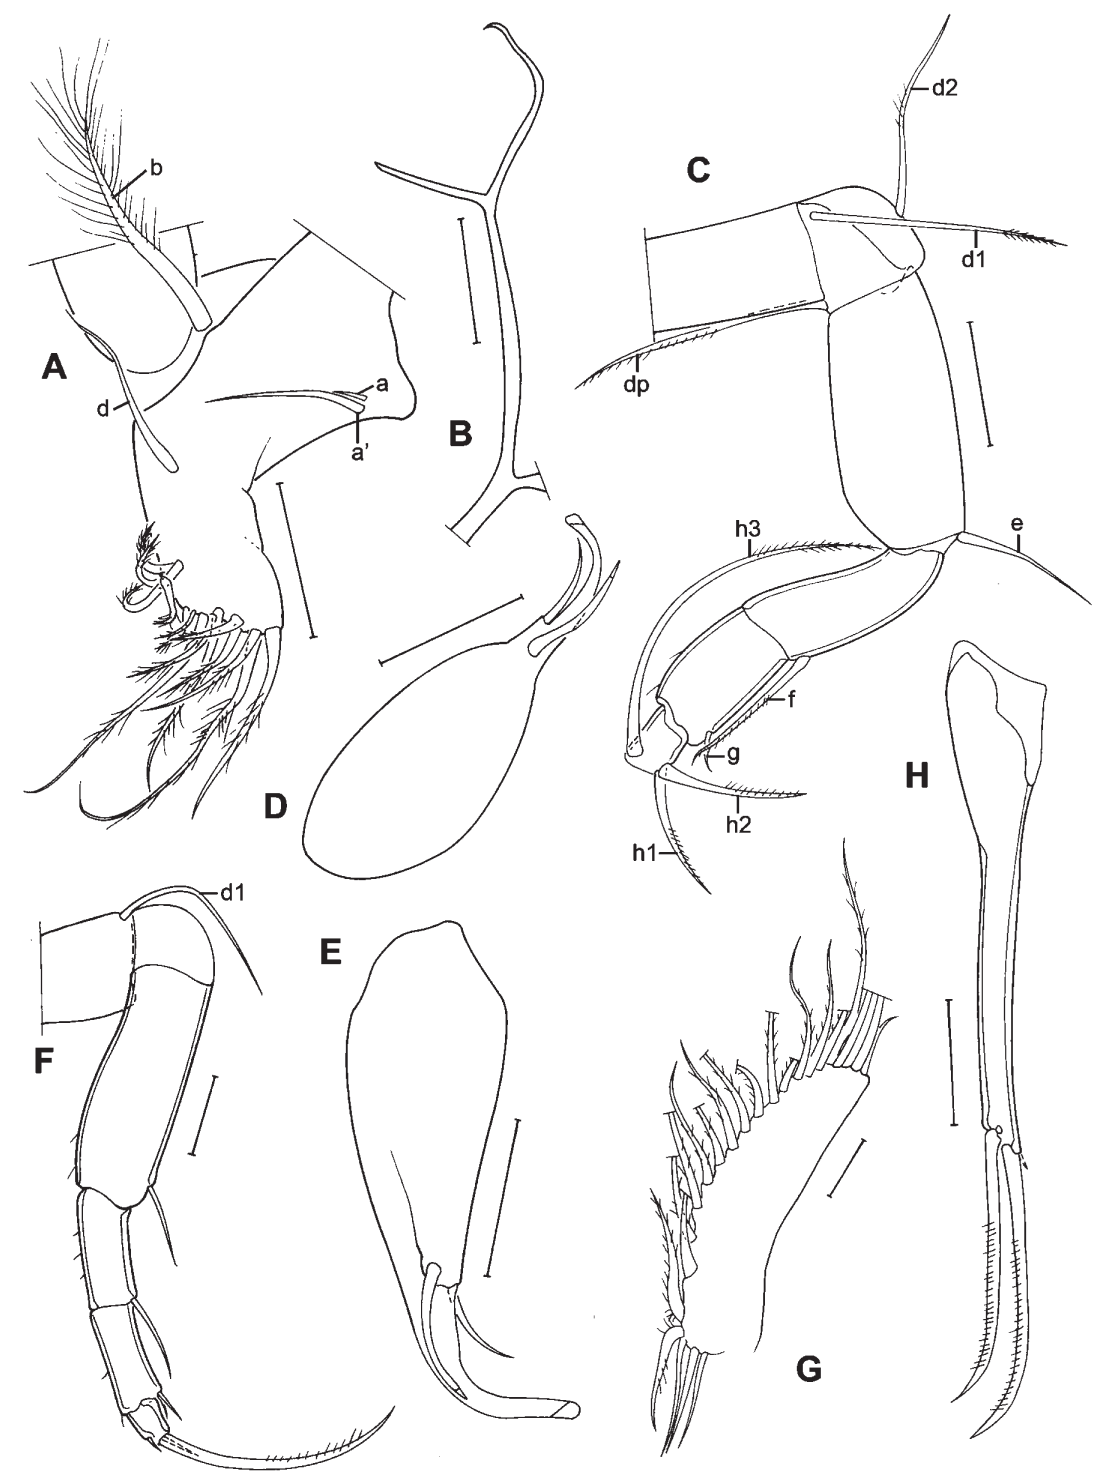
Fig. 10. Candobrasilopsis brasiliensis (Sars, 1901) comb. nov., limbs (♂). A . T1 (palp not shown) (MZUSP.28117). B . Attachment of the caudal ramus (OC.3295). C . T3 (MZUSP.28117). D . Right clasping organ (MZUSP.28117). E . Left clasping organ (MZUSP.28117). F . T2 (MZUSP.28117). G . Mx1, respiratory plate (OC.3296). H . Caudal ramus (OC.3295). Scale bars: A-H = 50